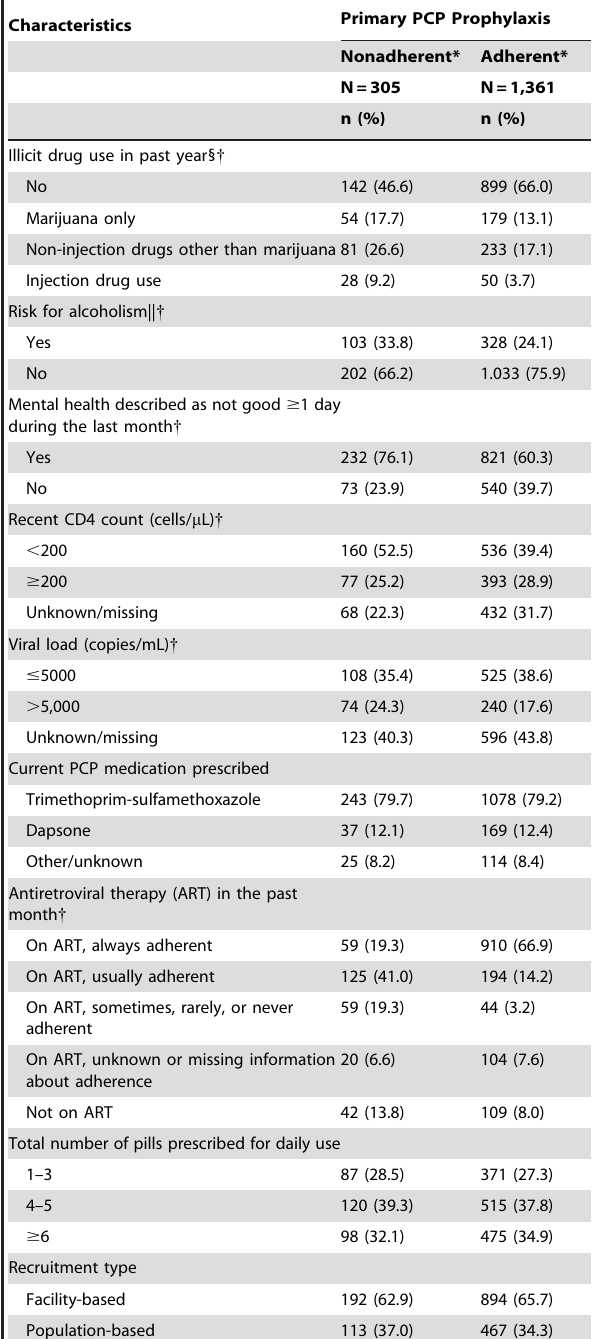
Characteristics Primary PCP